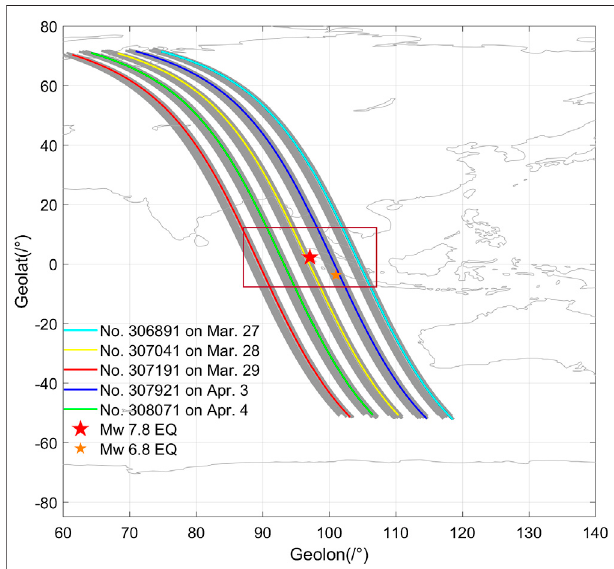
FIGURE3| Thetrajectoriesof fi veorbits(No.306891,307041,307191, 307921, and 308071, differently colored) with their revisiting orbits (gray lines) from August 2009 to May 2010. The red star represents the 2010 April 6, Mw 7.8 EQ,and theorange onedenotes the2010March 5, Mw6.8EQ. The red rectangle represents the area of